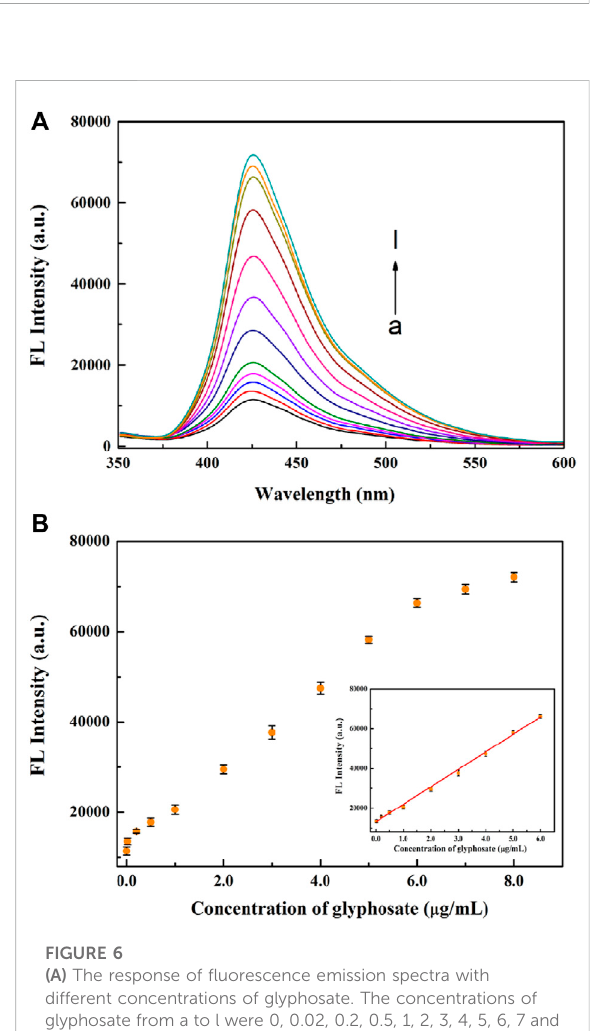
FIGURE 6 (A) The response of fl uorescence emission spectra with different concentrations of glyphosate. The concentrations of glyphosate from a to l were 0, 0.02, 0.2, 0.5, 1, 2, 3, 4, 5, 6, 7 and 8 μ g/ml, respectively. (B) The relationship between the fl uorescenceintensity andglyphosate concentrations. Inset:linear curve for glyphosate (0.02 – 6 μ